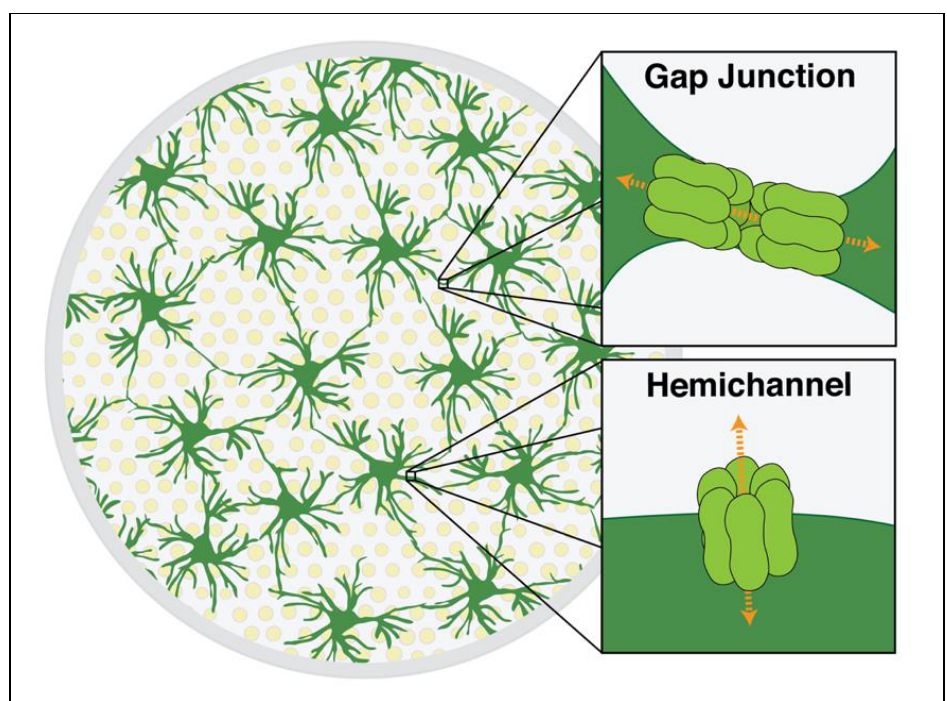
Figure 1. Schematic cross section of the rodent optic nerve head demonstrating Cx43 gap junctions and hemichannels. Optic nerve astrocytes (dark green) are arranged in a network that lies perpendicular to the direction of axons (yellow). These cells are interconnected via gap junctions composed of two adjoining hexamers of Cx43 (light green), as shown in the upper image inset. The junctions allow for electrical coupling and the nonselective passage of molecules up to ~1.2 kilodaltons in size from cell to cell. A single hexamer can also be unopposed on the astrocyte membrane, forming a hemichannel (lower inset). These can allow direct communication between the cytoplasmic and extracellular spaces.